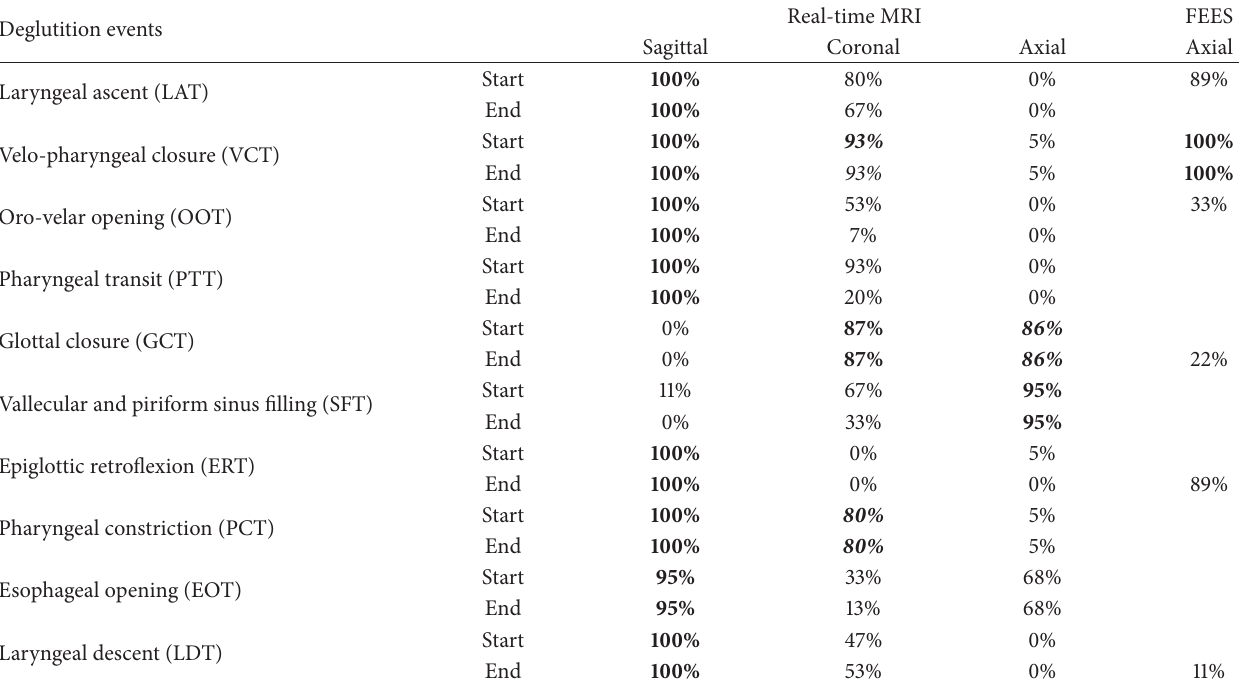
Table 2: Detectability of swallowing events by real-time MRI and